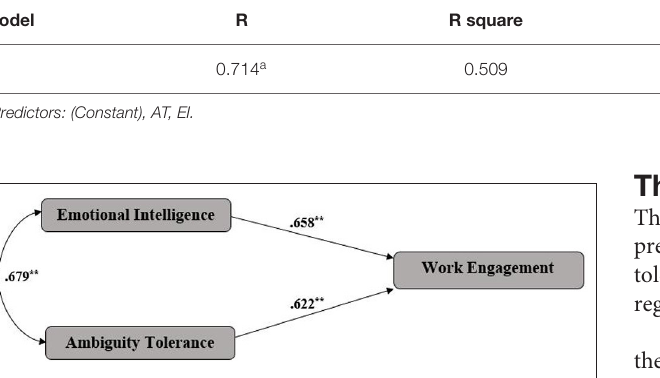
FIGURE 1 | Model of relationships between emotional intelligence, ambiguity tolerance, and work engagement. **Significant level (0.0 >